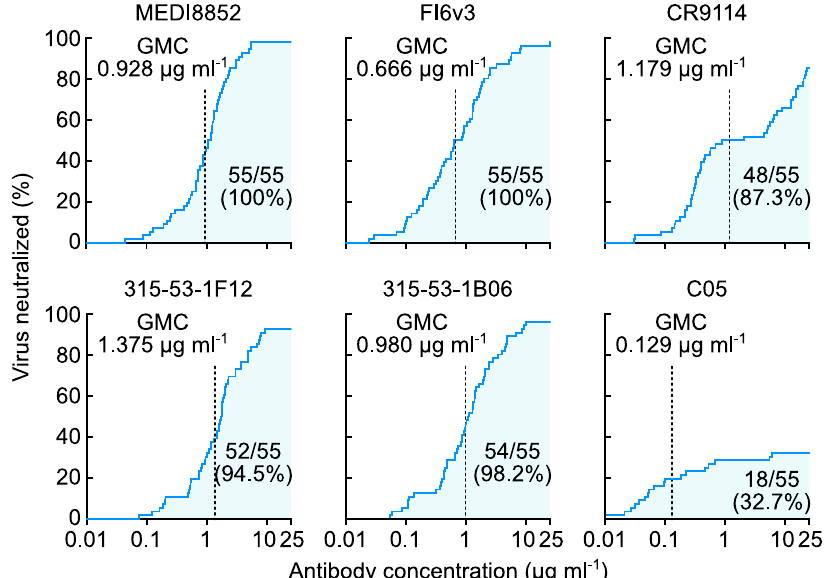
Fig. 6 Neutralization breadth-potency analysis of broadly cross-reactive stem-directed antibodies and highly potent receptor-binding site antibody. Neutralization titers (IC 80 µ g ml − 1 ) against a panel of 55 R3 viruses were used to generate the breadth-potency plot for each antibody. Geometric mean IC 80 concentration (GMC) of each antibody was calculated only for the viruses neutralized by given antibody and indicated as a vertical dashed line on each graph. Shaded areas correspond to the number of viruses neutralized by given antibody. Both the number of viruses neutralized out of 55 R3 viruses and neutralization coverage (%) are indicated on each